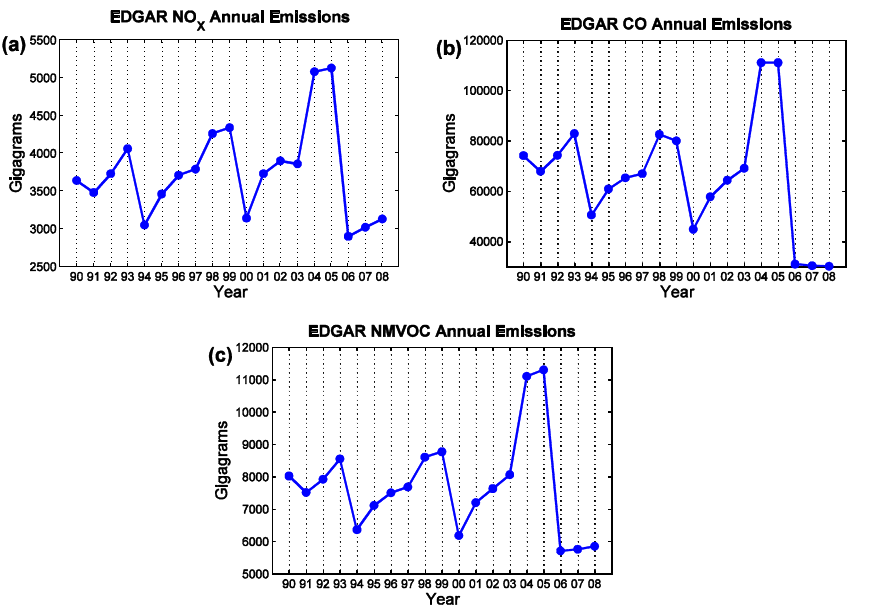
Figure 14. Same as Fig. 13 except for selected South American countries: Bolivia, Brazil, Paraguay and Uruguay. The countries were chosen based on the trajectories in Fig.